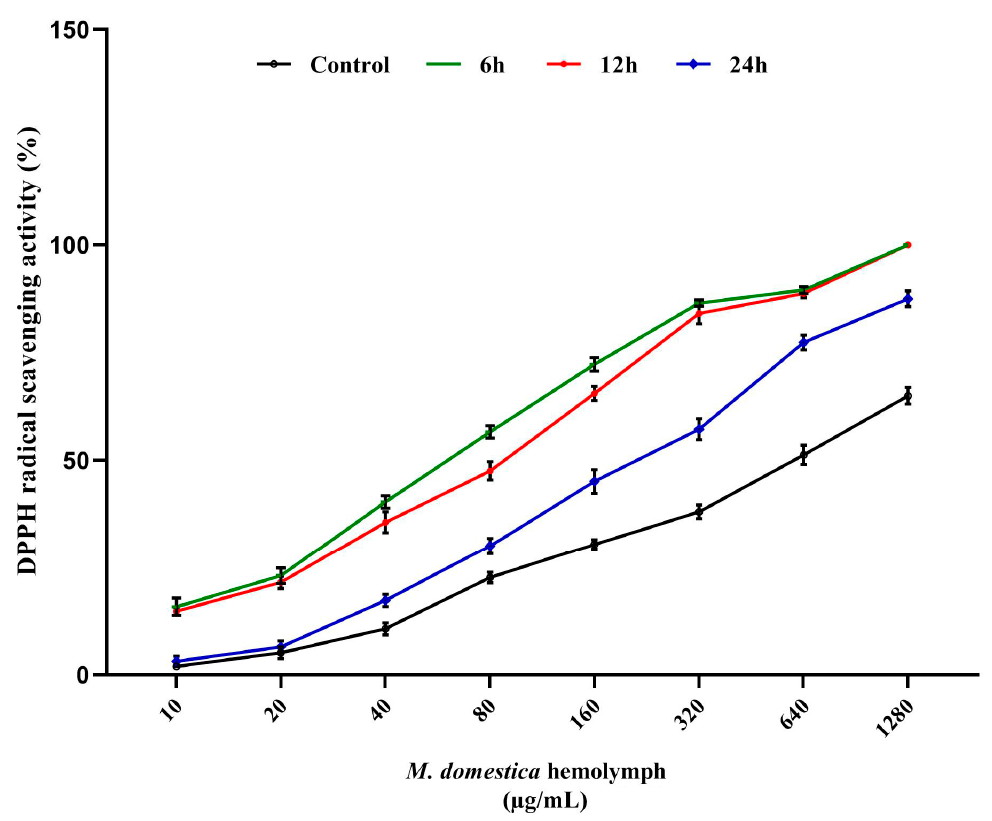
Figure 4. DPPH radical scavenging activities of M. domestica larval hemolymph. The graph is obtained by plotting different concentrations of larval hemolymph (10–1280 µg/µL) against the percent inhibition. Data were represented as mean ± SD ( n = 3).